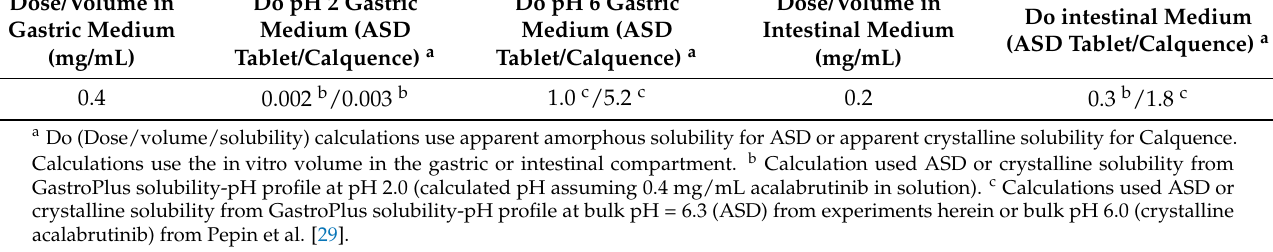
Table A5. Do (Dose number) calculations for USP 2 dissolution testing of ASD tablet and Calquence capsule. Dose/Volume